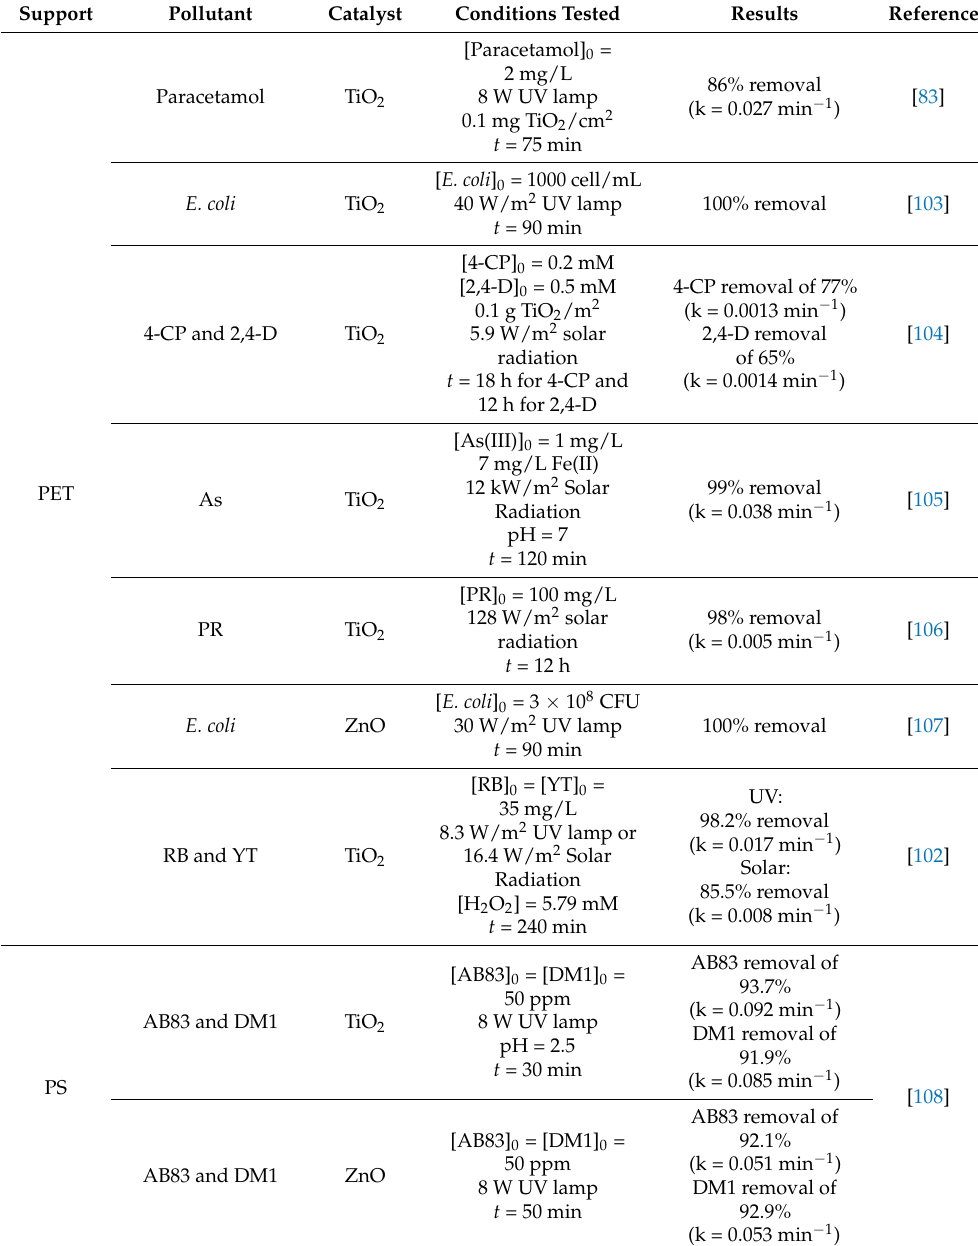
Table 16. Summary of the studies that have applied plastic wastes as supports in polymer-supported